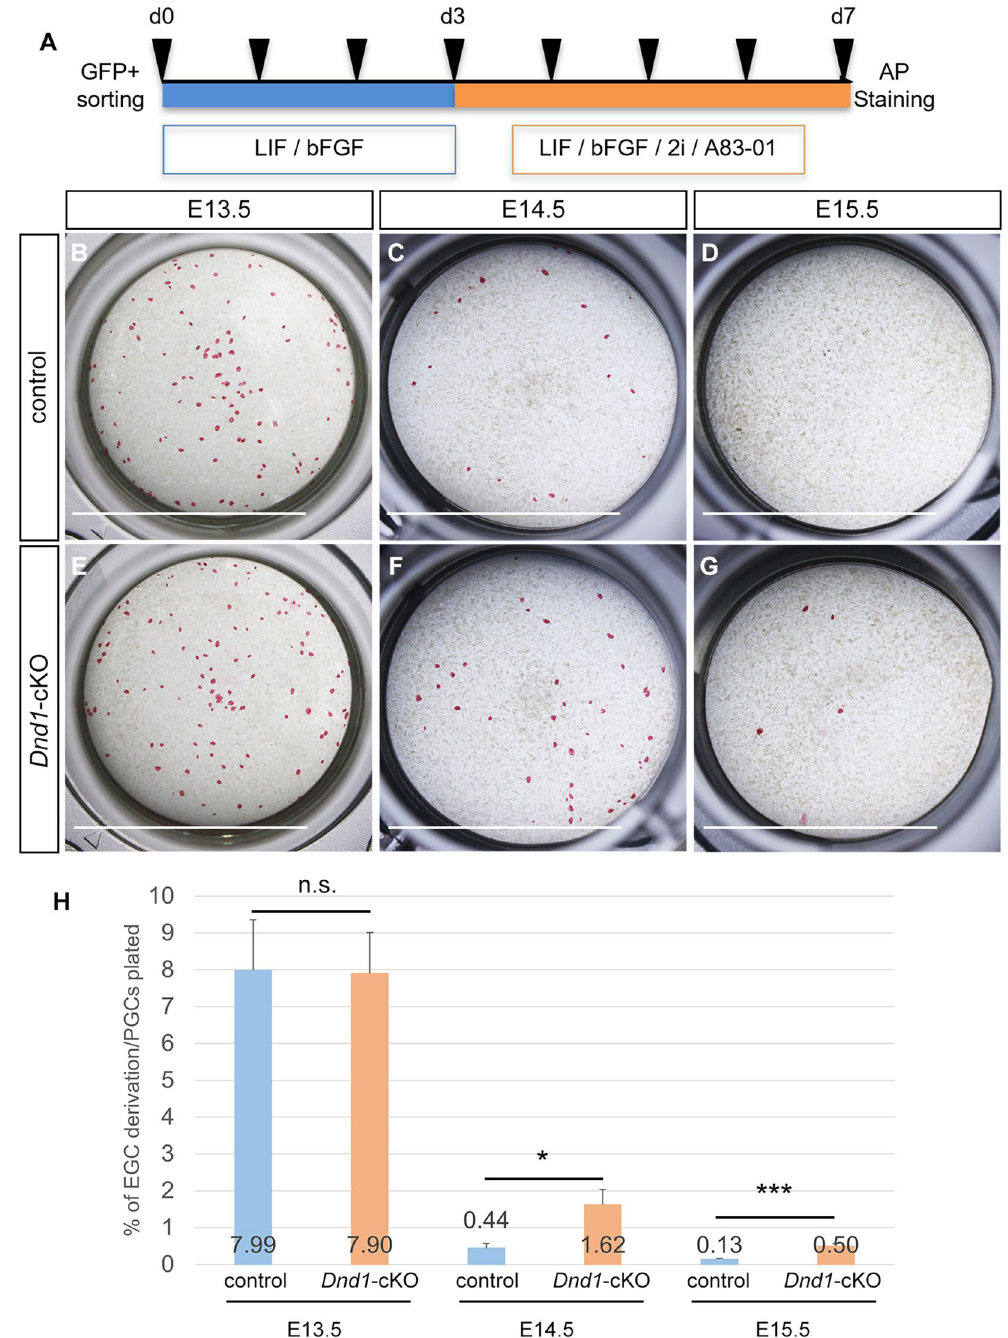
Figure 5. Increase in EGC formation in Dnd1- cKO PGCs. ( A ), Schematic representation of the culture conditions for deriving EGCs from PGCs. ( B – G ), Representative images of EGC colonies derived from EGFP- positive PGCs in the testes of control ( Dnd1 flox/flox ; Nanog-GFP ) ( B – D ) and Dnd1 -cKO ( Dnd1 flox/flox ; Nanog-GFP; Rosa26-CreER T2 ) ( E – G ) embryos at E13.5 ( B , E ), E14.5 ( C , F ), and E15.5 ( D , G ). EGC colonies were stained by alkaline phosphatase (AP) activity. Scale bars: 10 mm. ( H ), Rate of EGC derivation from EGFP-positive PGCs in the testes of control ( Dnd1 flox/flox ; Nanog-GFP ) and Dnd1 -cKO ( Dnd1 flox/flox ; Nanog-GFP; Rosa26-CreER T2 ) embryos. Black bars represent the mean ± SD. ** p < 0.01, *** p < 0.001 (Student’s t